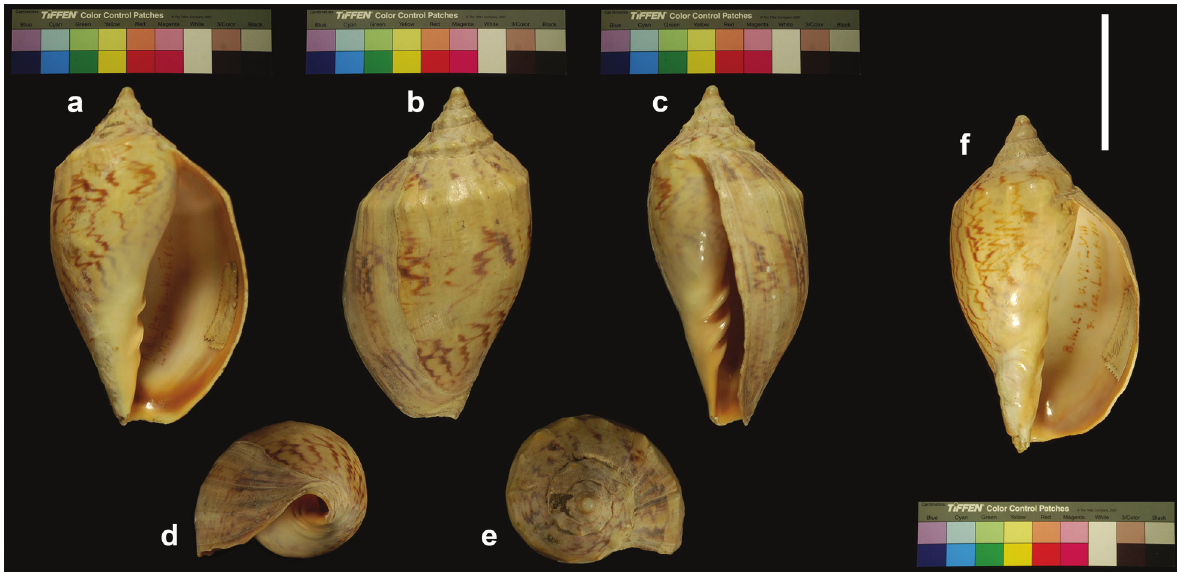
Figure 51. Voluta tuberculata decipiens . a–e Specimen figured by Lahille (1895: pl. VII, fig. 152; pl. XI, fig. 10) a Apertural view b Dorsal view c Lateral view d Umbilical view e Apical view f Specimen figured by Lahille (1895: pl. VII, fig. 151; pl. VIII, fig. 162) in apertural view. Scale bar: 5 cm.